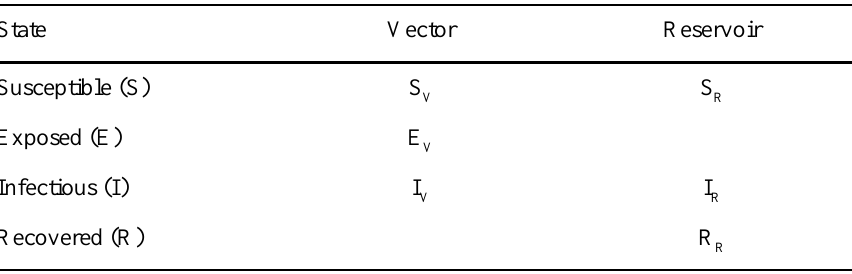
Table 2. Definition of the state variables modeled in the West Nile system of differential